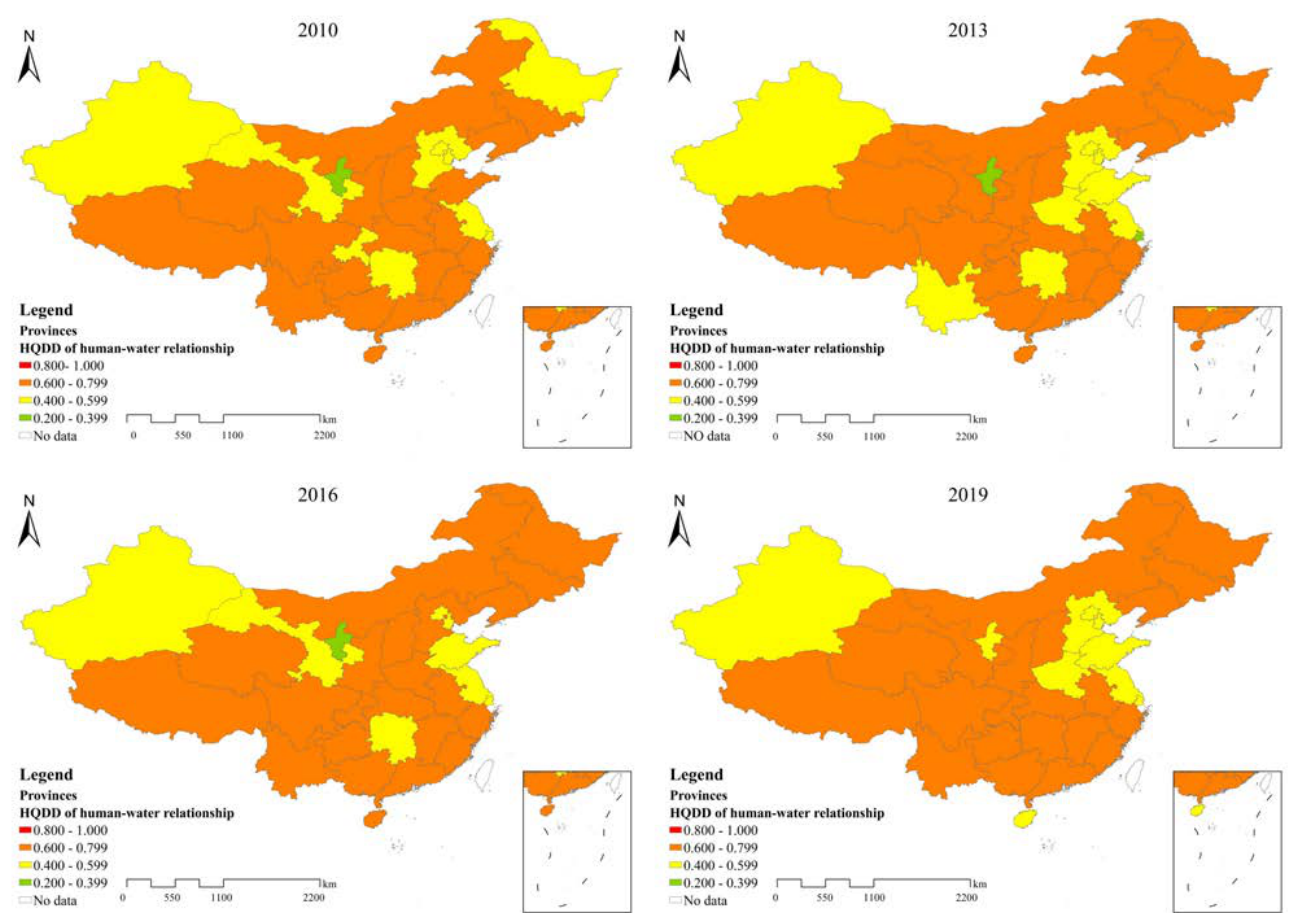
Figure 7. Spatial distribution of HQDD of the human-water relationship system in 31 PLARs in 2010, 2013, 2016, and 2019.